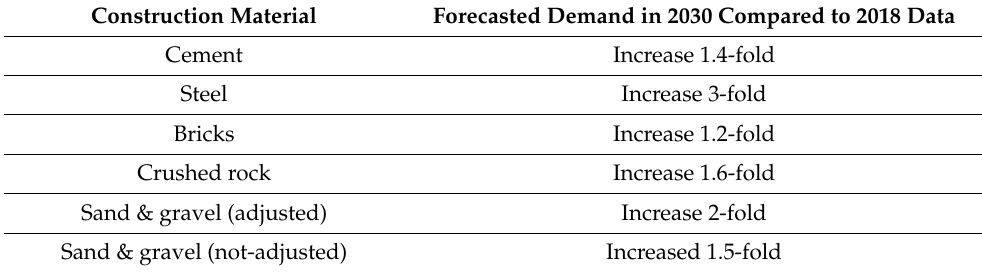
Table 3. Forecast material demand for the Hanoi Province.